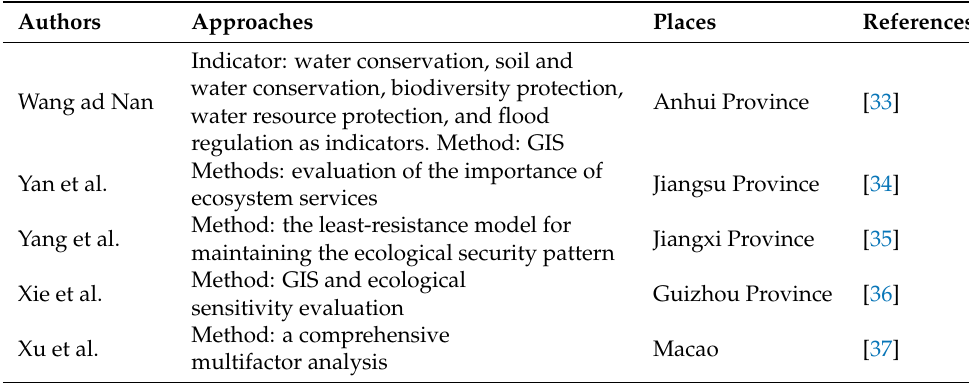
Table 1. Case study of delimiting ERLs in